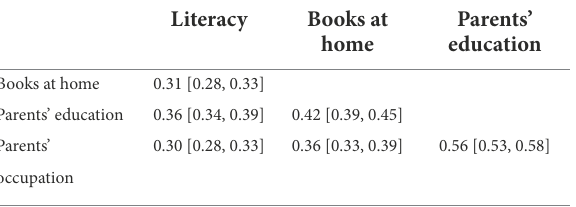
TABLE 3 Mean values of within-country correlations.